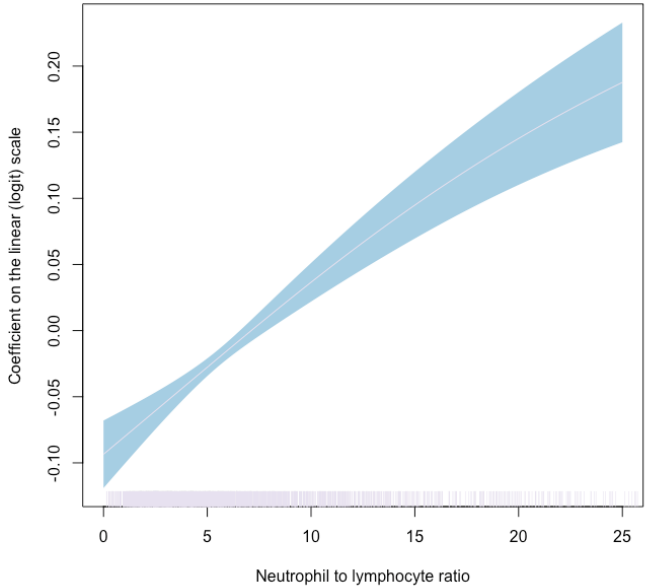
Figure 2. Results from a generalized additive model for the association between neutrophil to lym- phocyte ratio (NLR) and the risk of 30-day mortality in patients hospitalized with acute pulmonary embolism. The coefficient of NLR is shown. The ribbon around the line shows the standard error. The vertical marks at the bottom show the distribution of NLR values in the sample.